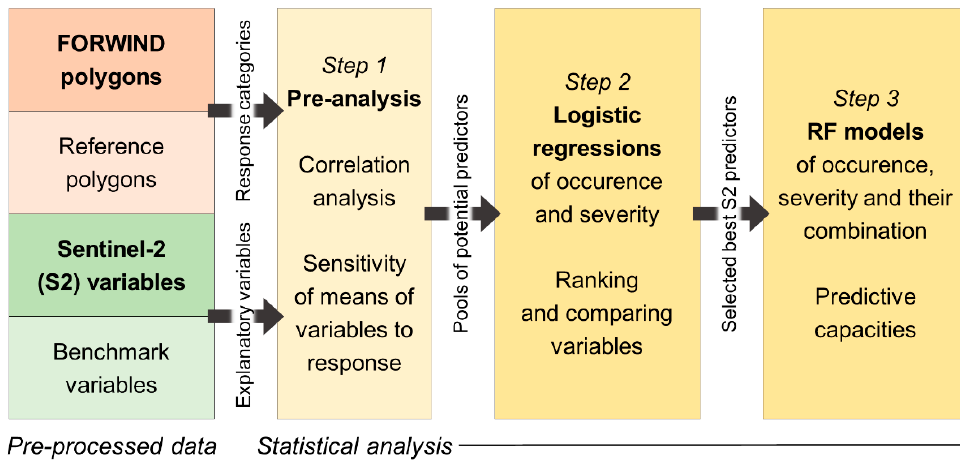
Figure 2. Schematic overview of the stepwise statistical analysis and modeling.